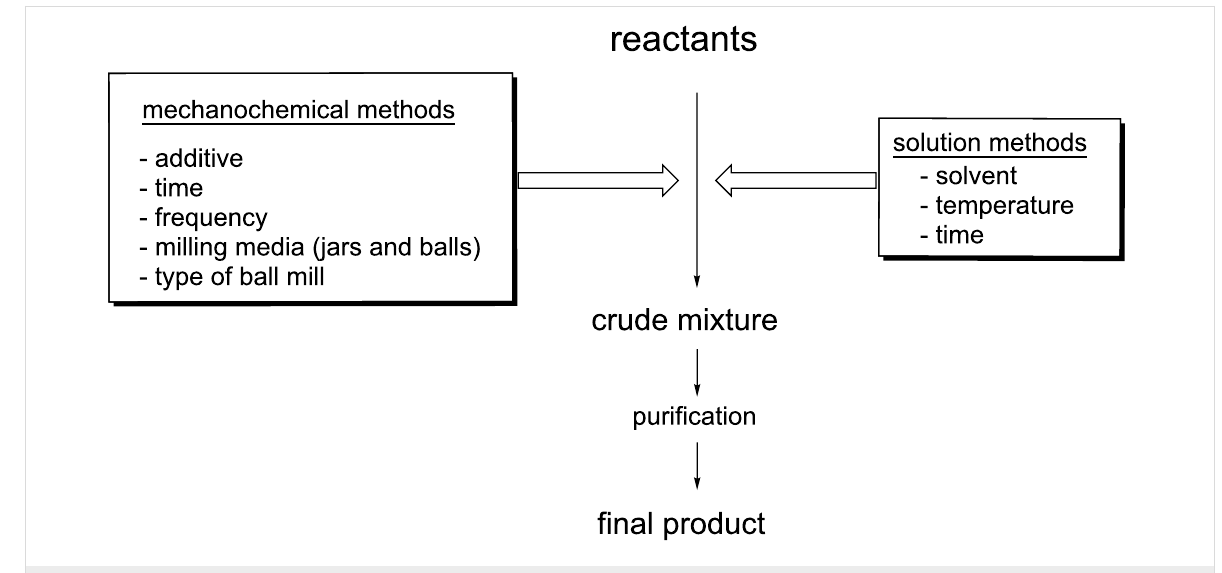
Scheme 1: Variables associated with ball-milling (left) and solvent-based methodologies